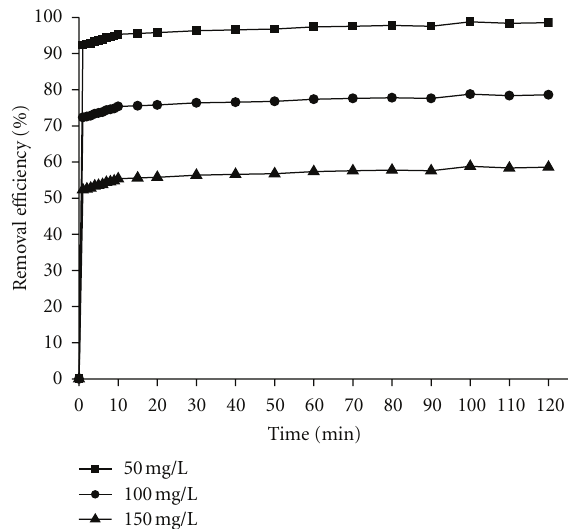
Figure 4: E ff ect of contact time on the removal of Pb 2+ at di ff erent initial concentrations. Adsorbent dose: 10 g/L, shaking rate: 200 rpm, pH: 5.5, T : 22 ± 2 o C.